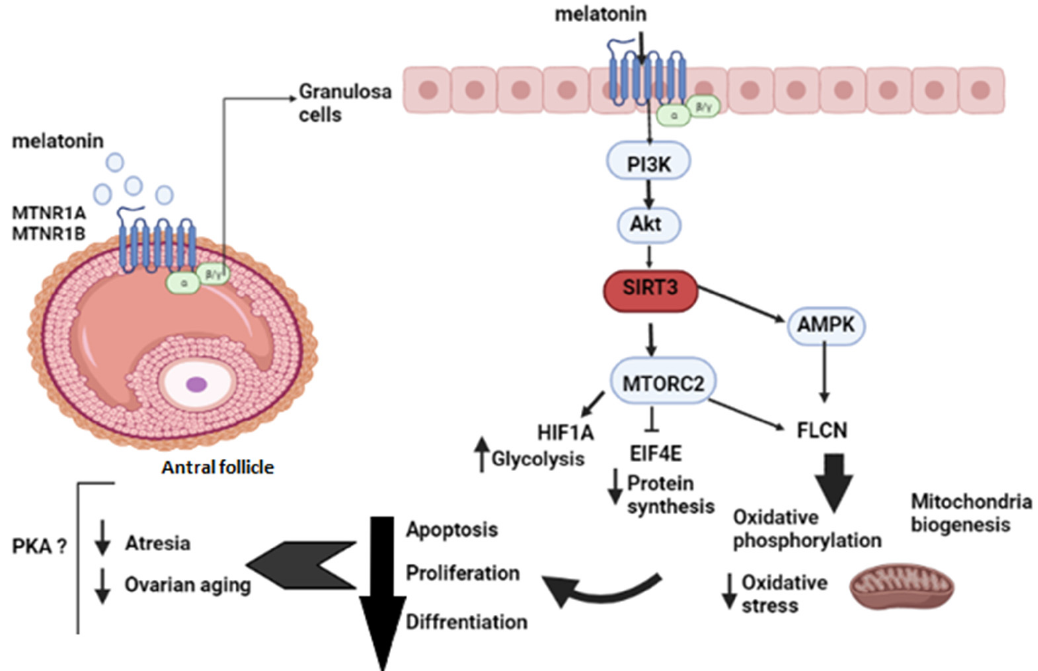
Figure 1. Melatonin effects on follicular development at the antral stage.